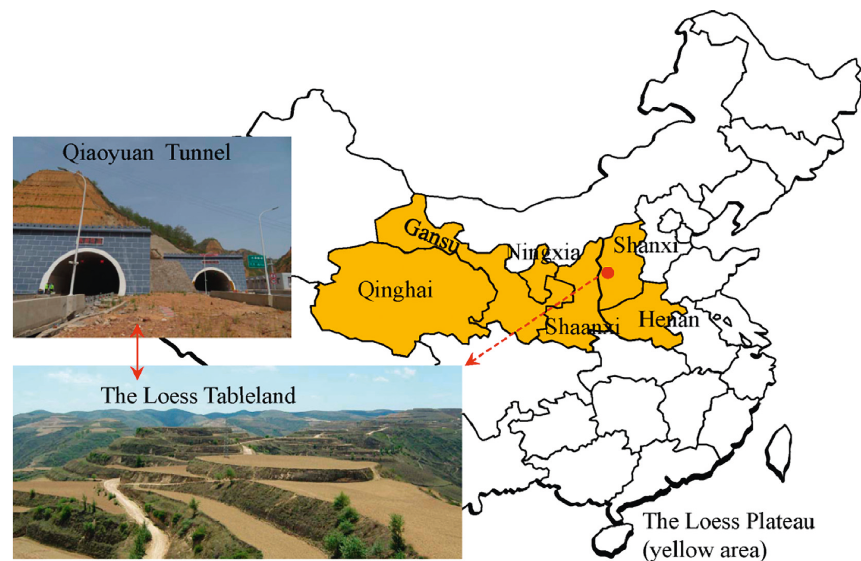
Figure 5: The location and topography of the Qiaoyuan